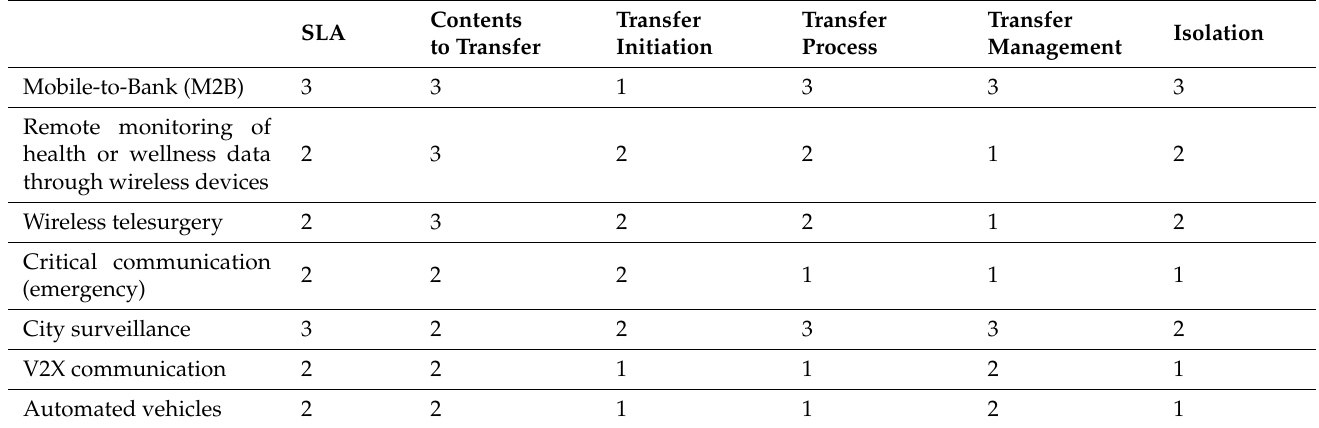
Table 15. The difficulty of solving the